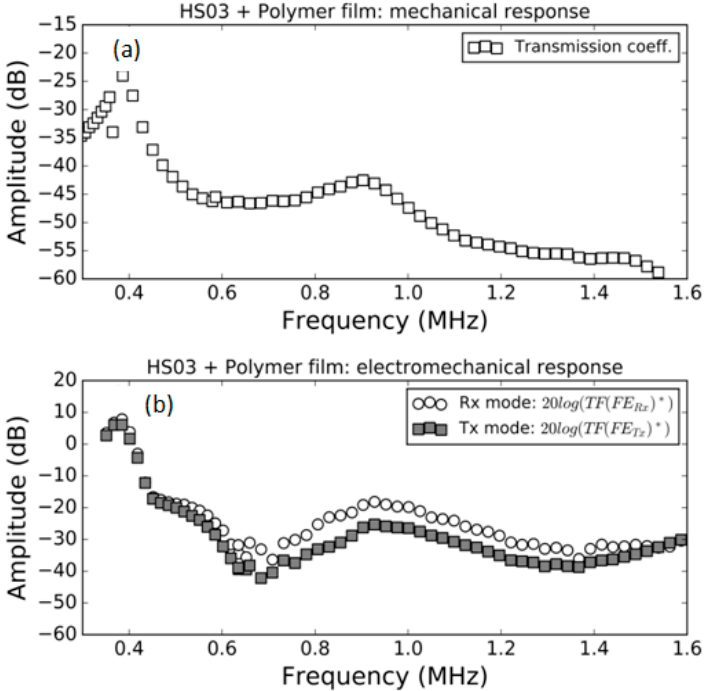
Figure 6. Measured response of the HS03 sample + film in air. ( a ) Modulus of the transmission coefficient vs. frequency; ( b ) electromechanical response vs. frequency both in Tx and Rx mode, (see Equations (16) and